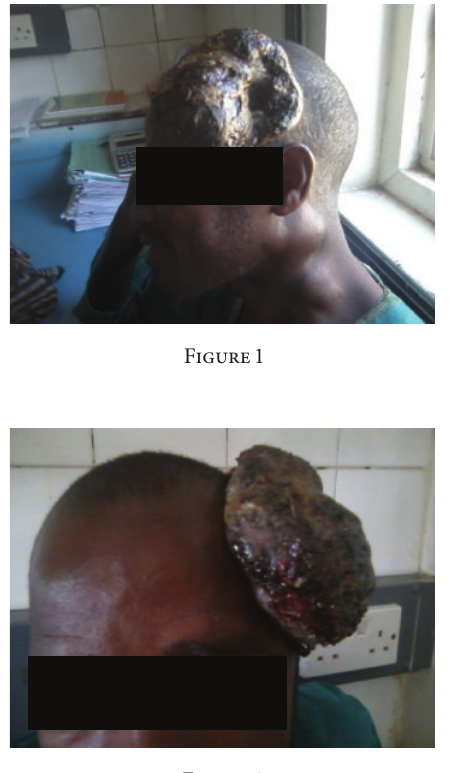
Figure 4: Photomicrograph of smear stained with H and E ×